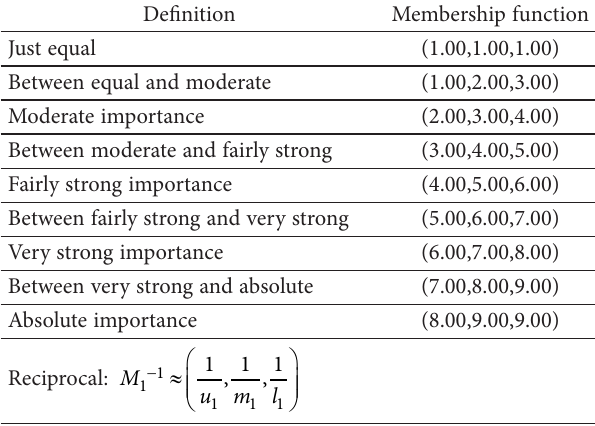
Table 2. The fuzzy